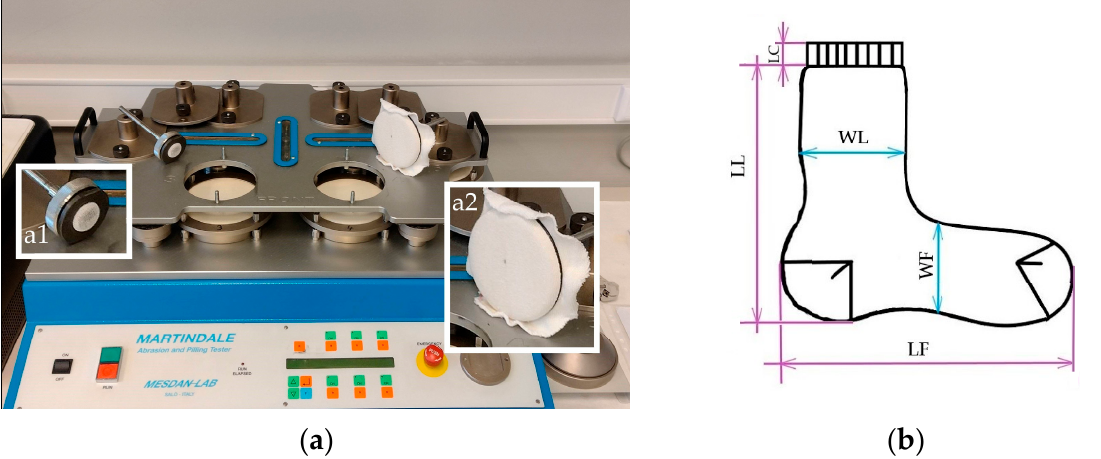
Figure 6. Evaluation of the usage properties of socks: ( a ) the device for determining the wear resistance of sock knits, Mesdan-Lab Martindale abrasion and pilling tester 2561 E, with (a1) the specimen holder for the abrasion resistance test and (a2) the specimen holder for the pilling test; ( b ) the measurement scheme for the dimensions of the socks: length of cuff, leg and foot part (LC, LL and LF); width of leg and foot part (WL and WF).